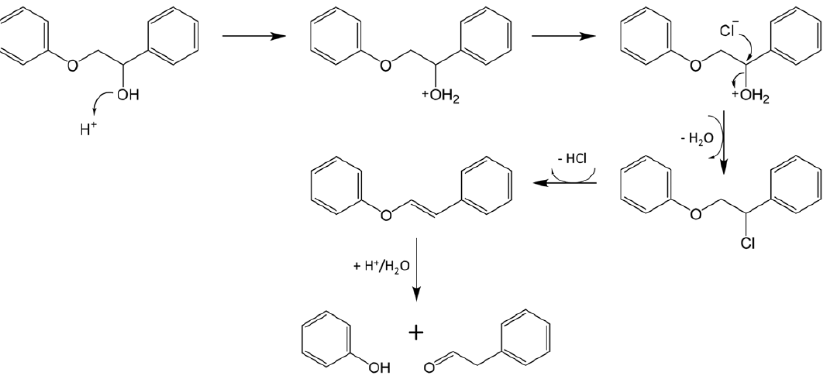
Figure 13. The proposed mechanism for the production of the chlorinated species. The same mech- anism can be considered for the brominated species. Reprinted from reference [100] with permis- sion.